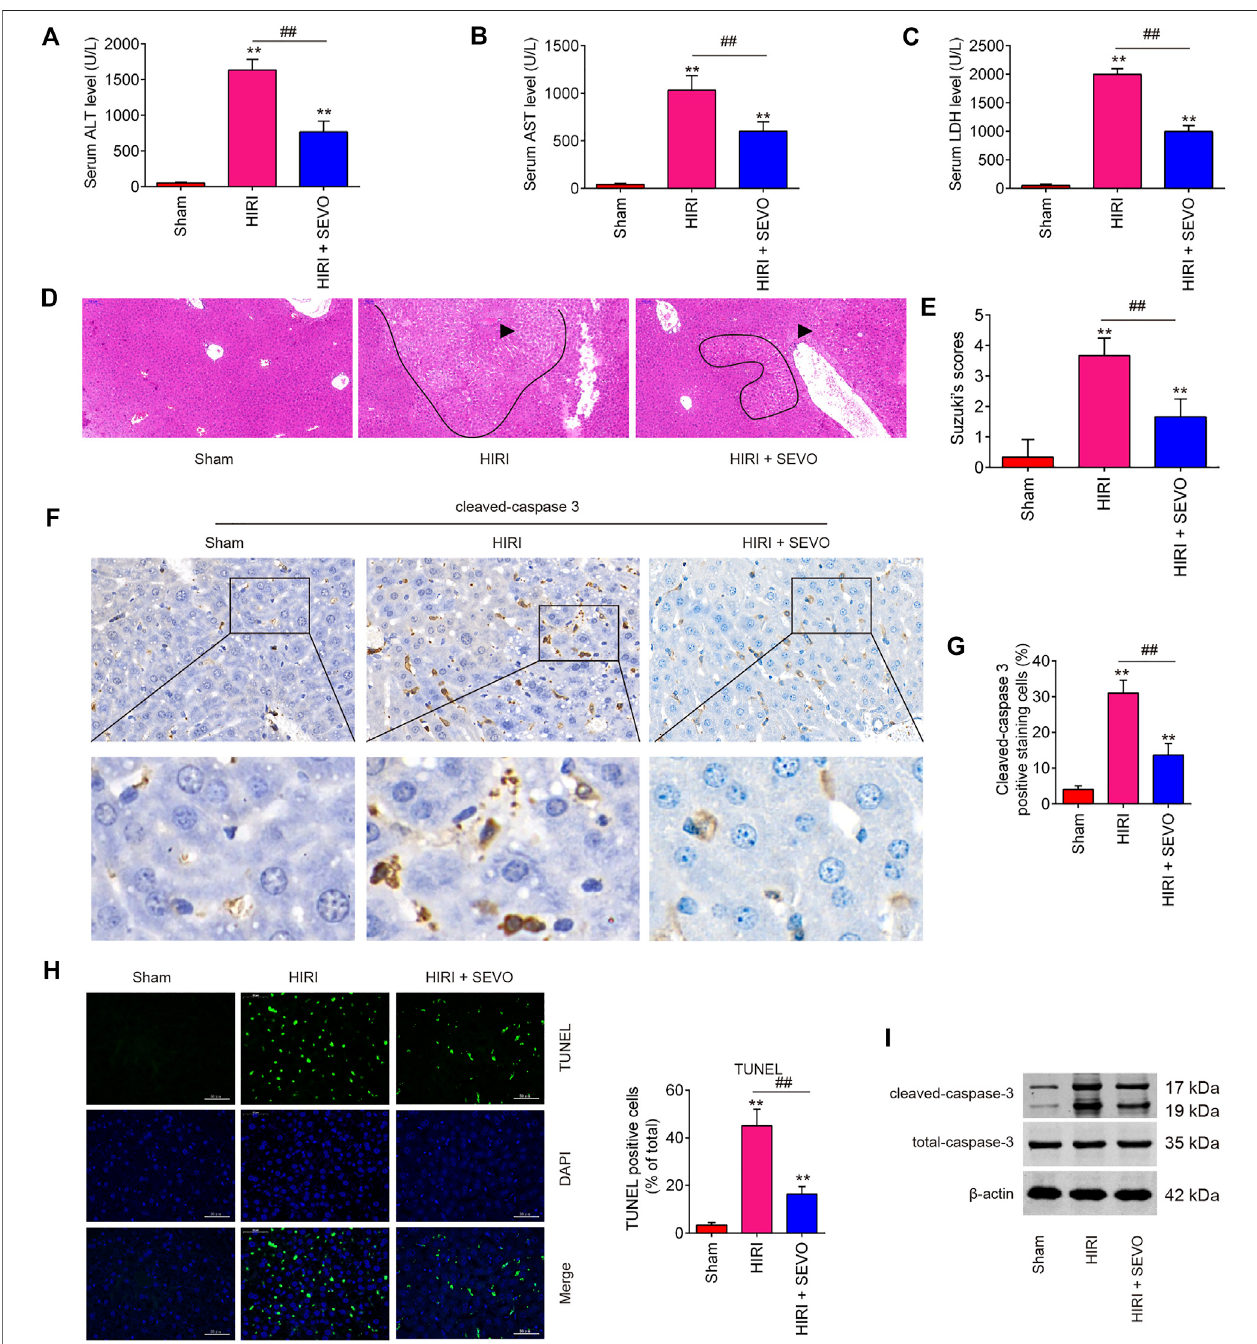
FIGURE 1 | Sevo fl urane postconditioning decreases hepatic I/R injury. Mice ( n (cid:2) 6/group) were subjected to ischemia, then post-treatment with inhalation of 2% Sevo for 2 h immediately at the onset of reperfusion. (A) Liver enzyme assays were performed in the three groups: sham, HIRI and HIRI + Sevo groups. (A) : Serum ALT levels; (B) : Serum AST levels; (C) : Serum LDH levels). (D, E) Liver damage induced by I/R was visualized using HE staining and was graded using the Suzuki score. The in fl ammatory cell in fi ltration is indicated with black arrow and necrotic areas is indicated with curve. (F, G) The expression of cleaved-caspase-3 was measured by IHC. (H) The apoptosis was determined by TUNEL staining assay. (I) The expression of cleaved caspase-3 was detected by Western Blot. All data were measurement data which were expressed as mean ± standard deviation and analyzed by one-way analysis of variance. ** p < 0.01 vs. Sham group; ## p < 0.01 vs. HIRI group.